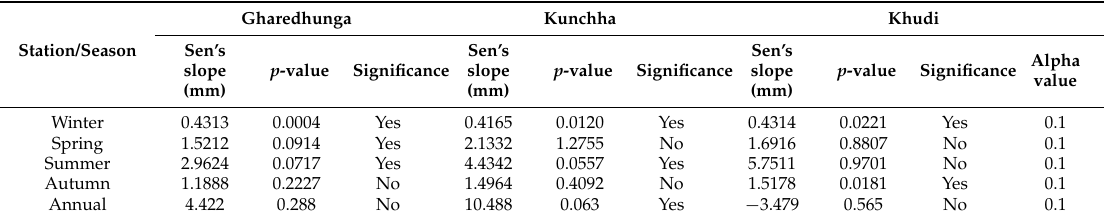
Figure 3. Seasonal precipitation trends at Gharedhunga, Kunchha and Khudi stations from 1980 to 2012. Table 3. Sen’s slope values for seasonal and annual precipitation at the three stations.